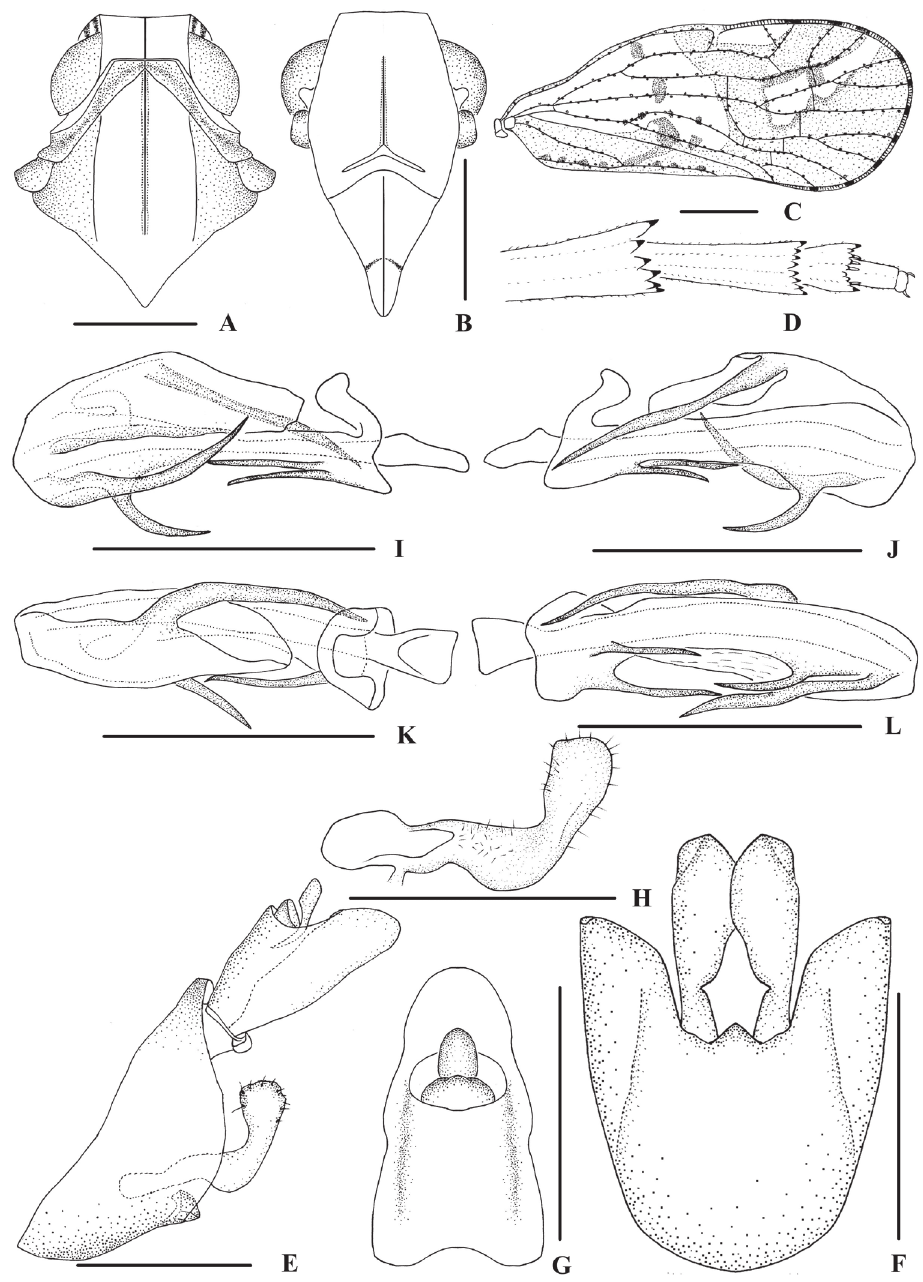
Figure 2. Kirbyana aspina sp. nov., male A head and thorax, dorsal view B face, ventral view C forewing D apex of left hind leg, ventral view E genitalia, lateral view F pygofer and gonostyli, ventral view G anal segment, dorsal view H gonostyli, inner lateral view I aedeagus, right side J aedeagus, left side K aedeagus, dorsal view L aedeagus, ventral view. Scale bars: 0.5 mm ( A, B, E–L ); 1.0 mm ( C